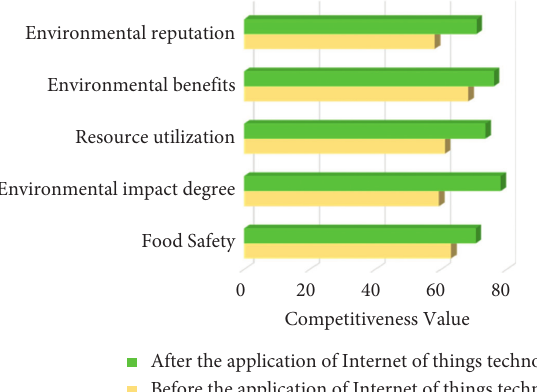
Figure 9: Comparison of competitiveness values of subindicators of green dimension.